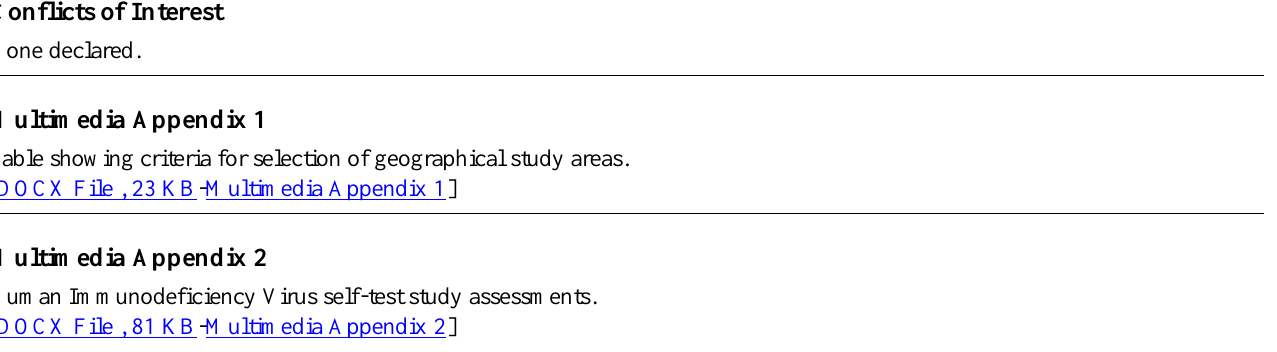
Table showing criteria for selection of geographical study